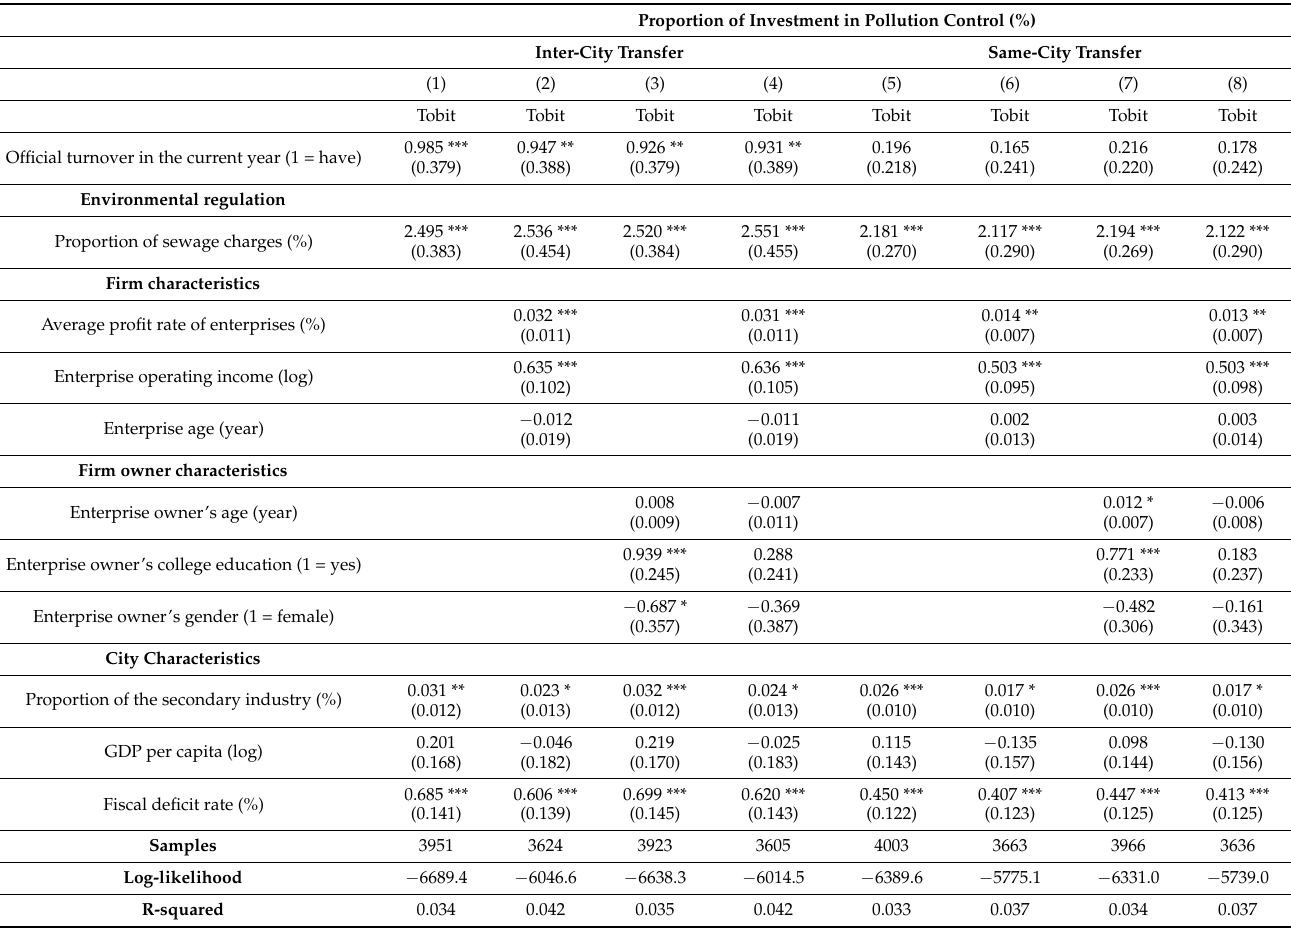
Table 4. The differences in environmental effects between officials transferred from different places and transferred from the same